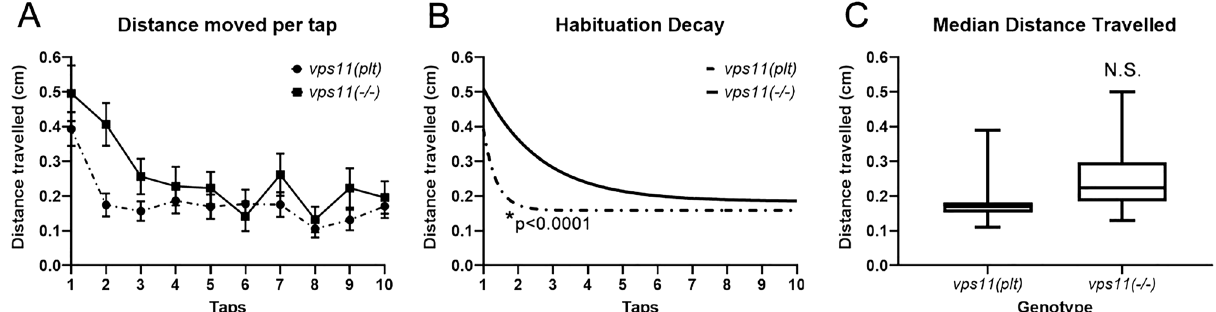
Figure 8. vps11(plt) and vps11 (−/−) mutants show different rates of habituation response to multiple high intensity acoustic/tap stimuli. ( A ) Graph representing average distance moved by vps11(plt) (dashed line; n = 64) and vps11 (−/−) (solid line; n = 44) larvae at each individual tap stimuli. B. First order exponential decay curve representing average distance travelled by vps11(plt) (dashed line; n = 64) and vps11 (−/−) (solid line; n = 44) larvae at each individual tap stimuli * P < 0.0001. ( C ) Box-plots representing the average distance travelled by vps11(plt) (n = 64) and vps11 (−/−) (n = 44) larvae at all 10 tap stimuli. Error bars indicate